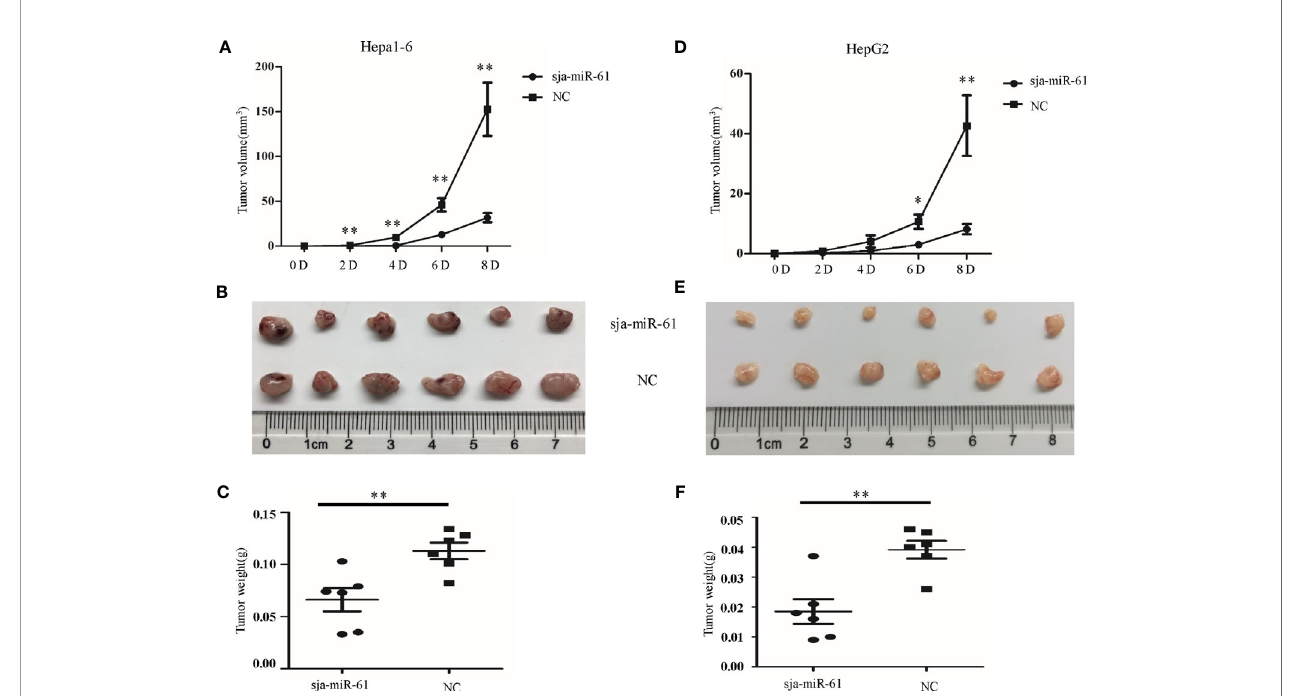
FIGURE 2 | Sja-miR-61-mediated suppression of hepatoma growth in vivo . Hepa1-6 and HepG2 cells were transfected with sja-miR-61 mimics or NC mimics, respectively, and then the sja-miR-61-transfected cells (1×10 6 ) were injected subcutaneously to the left scapula of athymic nude mice, and the NC-transfected cells to the right scapula (n = 6), respectively. Tumor volumes were measured at days 2, 4, 6, and 8 after injection. At day 8, the mice were sacri fi ced and tumors were separated to measure their weight and volume, (A – C) for Hepa1-6 cells, (D – F) for HepG2 cells. Data are presented as the mean ± SD, n = 6, * p < 0.05, ** p <